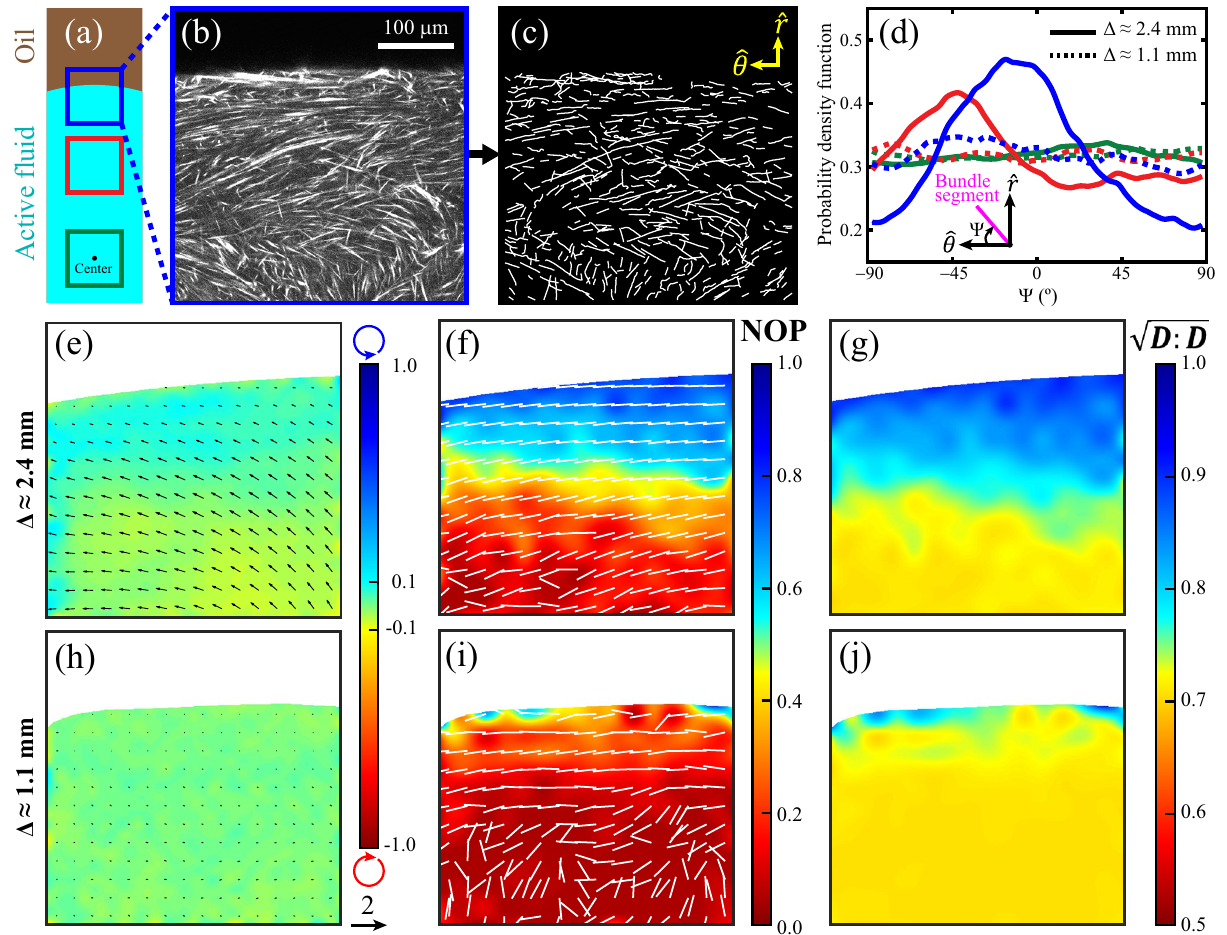
Figure 4. Intradroplet circulatory flows were accompanied by the formation of a weak nematic layer in the microtubule network structure near the water–oil interface. A droplet (radius = 2.4 mm; height = 1 mm) was immersed in an oil layer of thickness (Δ) 2.4 mm and developed an intradroplet circulatory flow. ( a ) Microtubule network structures were imaged with a confocal microscope at three locations: the water–oil interface (blue), ~ 400 µm from the interface (red), and the droplet center (green). ( b ) Confocal image of the microtubule network at the droplet midplane. ( c ) Corresponding network structure extracted with the snake algorithm 41 . ( d ) Orientational distributions of microtubule bundles when intradroplet flows were circulating (solid, Δ ≈ 2.4 mm) and not circulating (dashed, Δ ≈ 1.1 mm). Blue, red, and green curves represent the locations within the droplet indicated in panel a . In circulating flows, most microtubule bundles near the interface were aligned at angles of ~ 15° from the interface (solid blue curve), and most microtubule bundles 400 µm from the interface were aligned at angles of ~ 45° (solid red curve). In noncirculating flows, the bundles were oriented isotropically (dotted curves). ( e–j ) Time-averaged velocity fields and vorticity maps of microtubule flows (panels e and h , plotted as in Fig. 1c), director fields and nematic order parameter